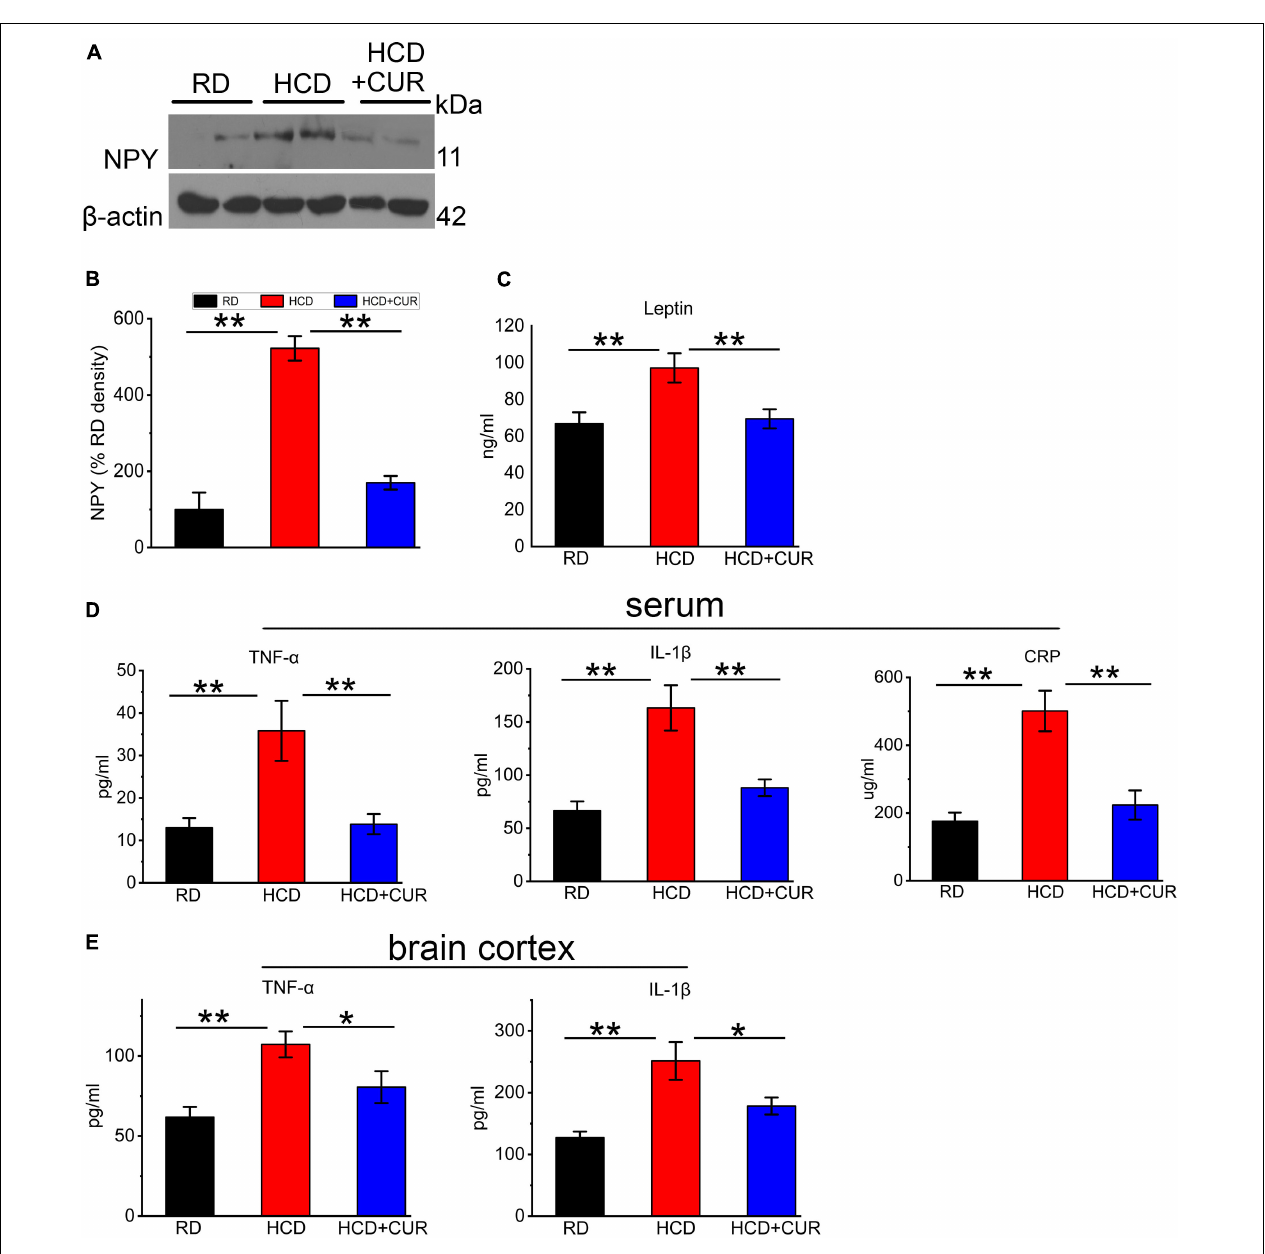
FIGURE 6 | Changes in NPY level in hypothalamus and leptin, TNF- α , IL-1 β , and CRP in plasma and/or cerebral cortex in rats. (A,B) Representative western blot of NPY in hypothalamus. Quantification of nuclear NPY normalized with β -actin. Data are expressed as mean ± SE, n = 4 for each group. (C) Leptin in plasma; (D) TNF- α , IL-1 β , and CRP in plasma; (E) TNF- α and IL-1 β in cerebral cortex. RD, control group; HCD, high cholesterol diet group; HCD + CUR, high cholesterol diet receiving a daily dose of 200 mg/kg body weight curcumin by gavage for 4 weeks. Carotid injury was induced by an air-drying endothelial denudation method at the end of the second week. Data are representative of two independent experiments and are expressed as mean ± SE, n = 10 for each group. * P < 0.05, ** P <